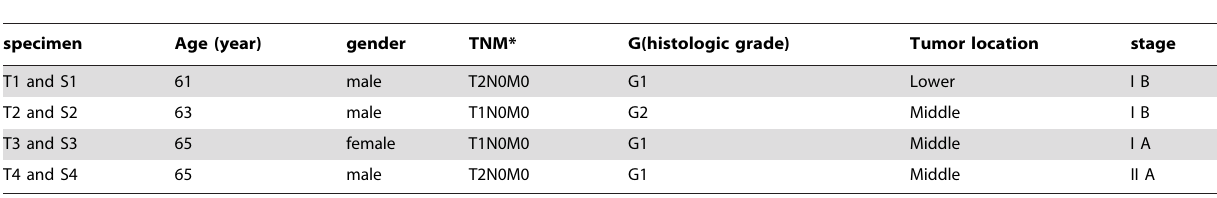
Table 1. Clinic information of the 4 ESCC patients whose samples were used for methylation array.